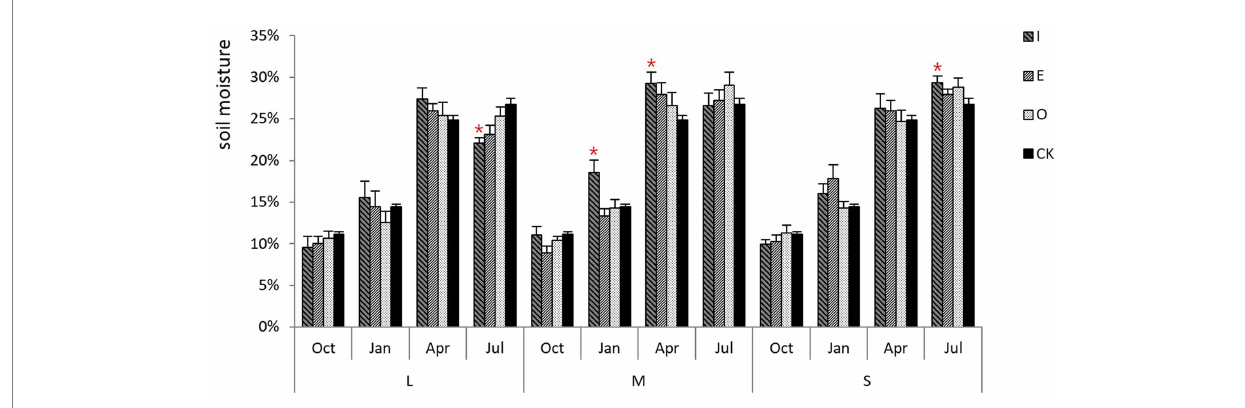
FIGURE 3 Soil moisture in different sizes of gaps in Platycladus orientalis plantation, the “*“signs represent significant